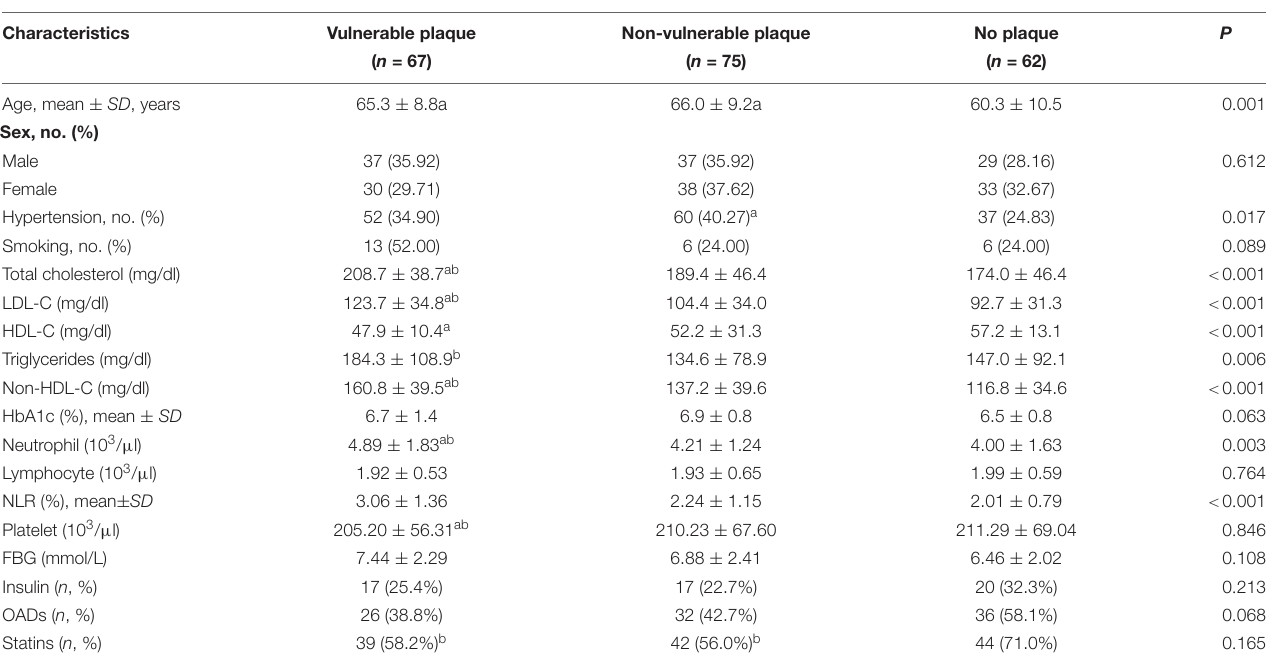
a P means compared with non-plaque group. b P means compared with the non-vulnerable plaque group.